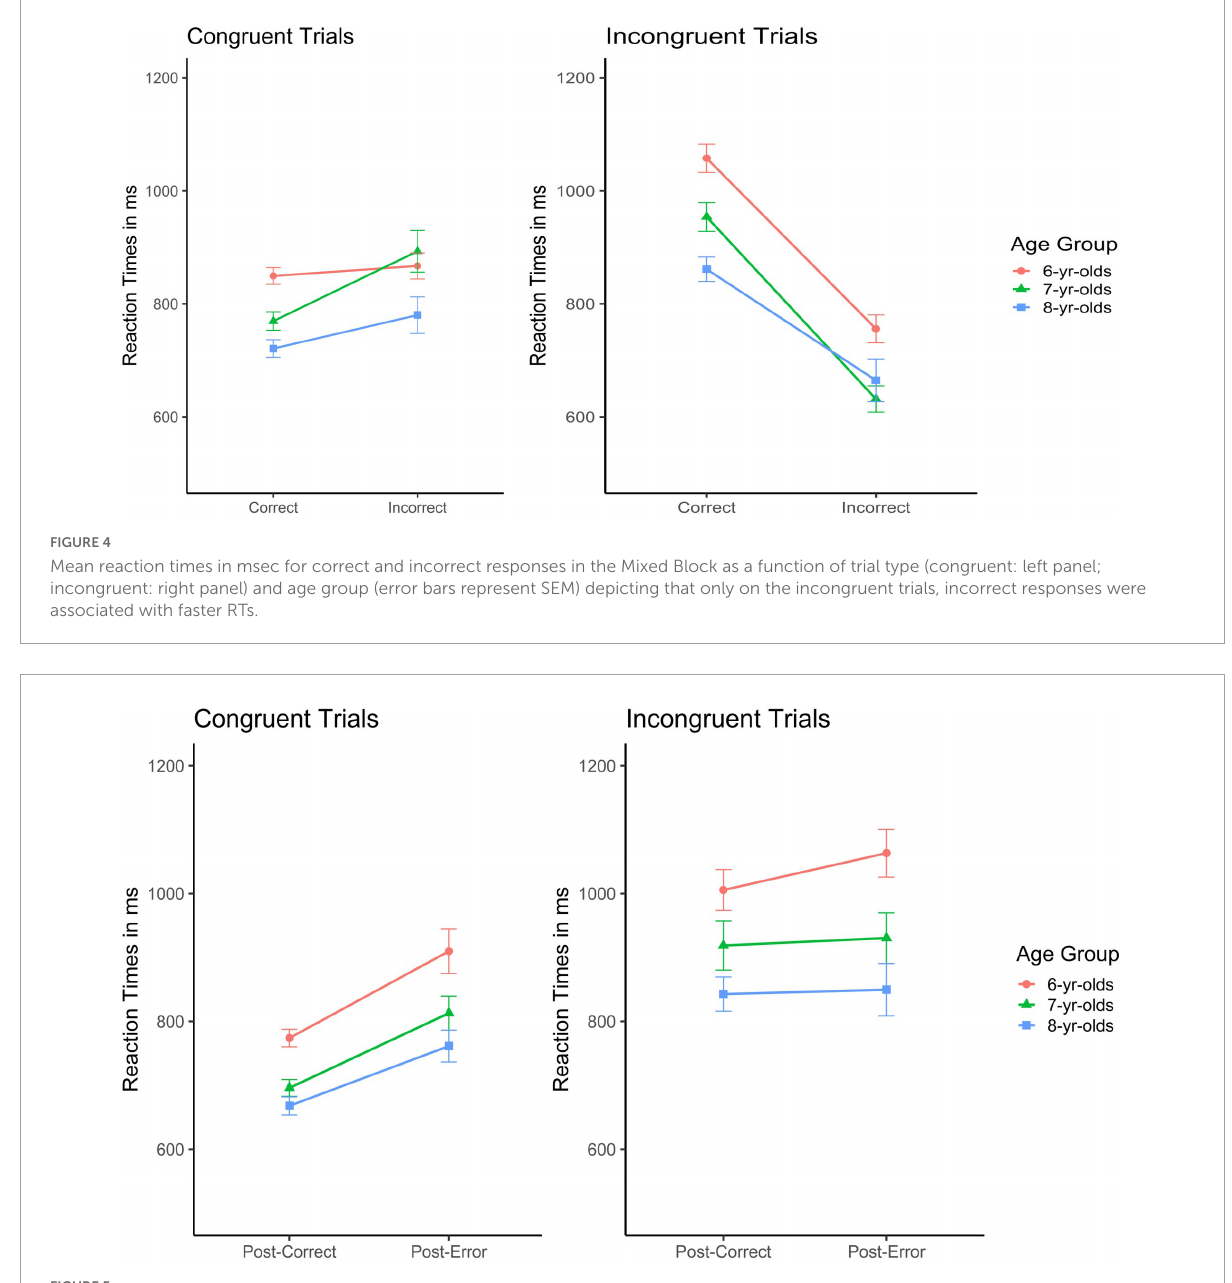
FIGURE5 Mean reaction times in msec for post- correct and post-error trials in the Mixed block as a function of trial type (congruent: left panel; incongruent: right panel) and age group (error bars represent SEM) showing that post-error slowing in the Mixed Block showed an inconsistent